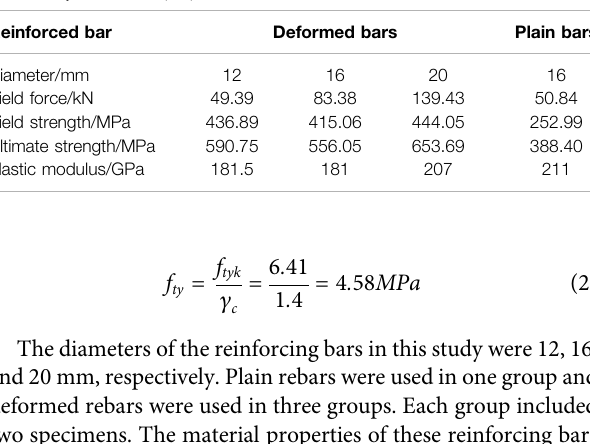
TABLE 3 | Mechanical properties of